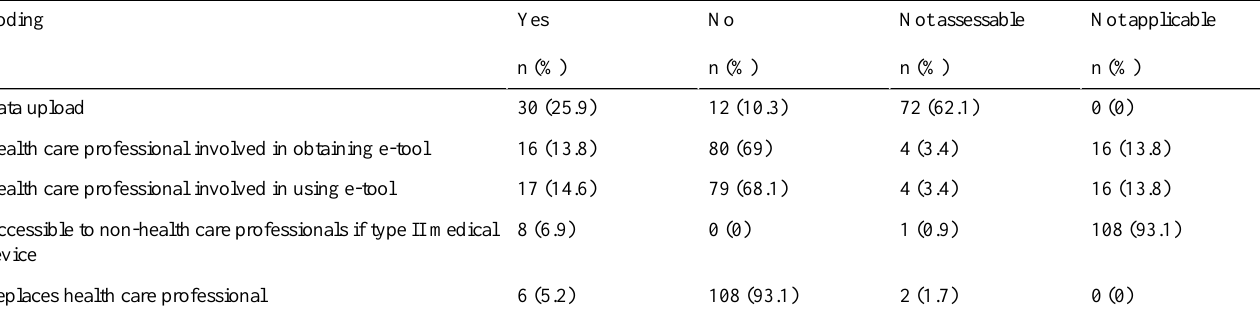
Table 2. Assessment of possible risks of apps and other e-tools for medication use, based on tool characteristics; data is presented as percentage of total number of tools investigated (N=116).